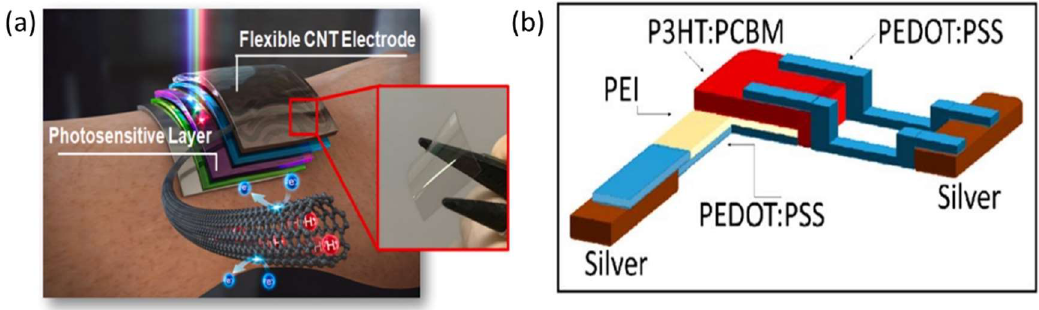
Figure 2. ( a ) Schematic of the device with flexible CNT electrode, reprinted with permission from [23] ©2021 Elsevier. And ( b ) vertical stack of the device with modified PEDOT:PSS flexible electrode, Reprinted with permission from [78] ©2018 ACS Publications .